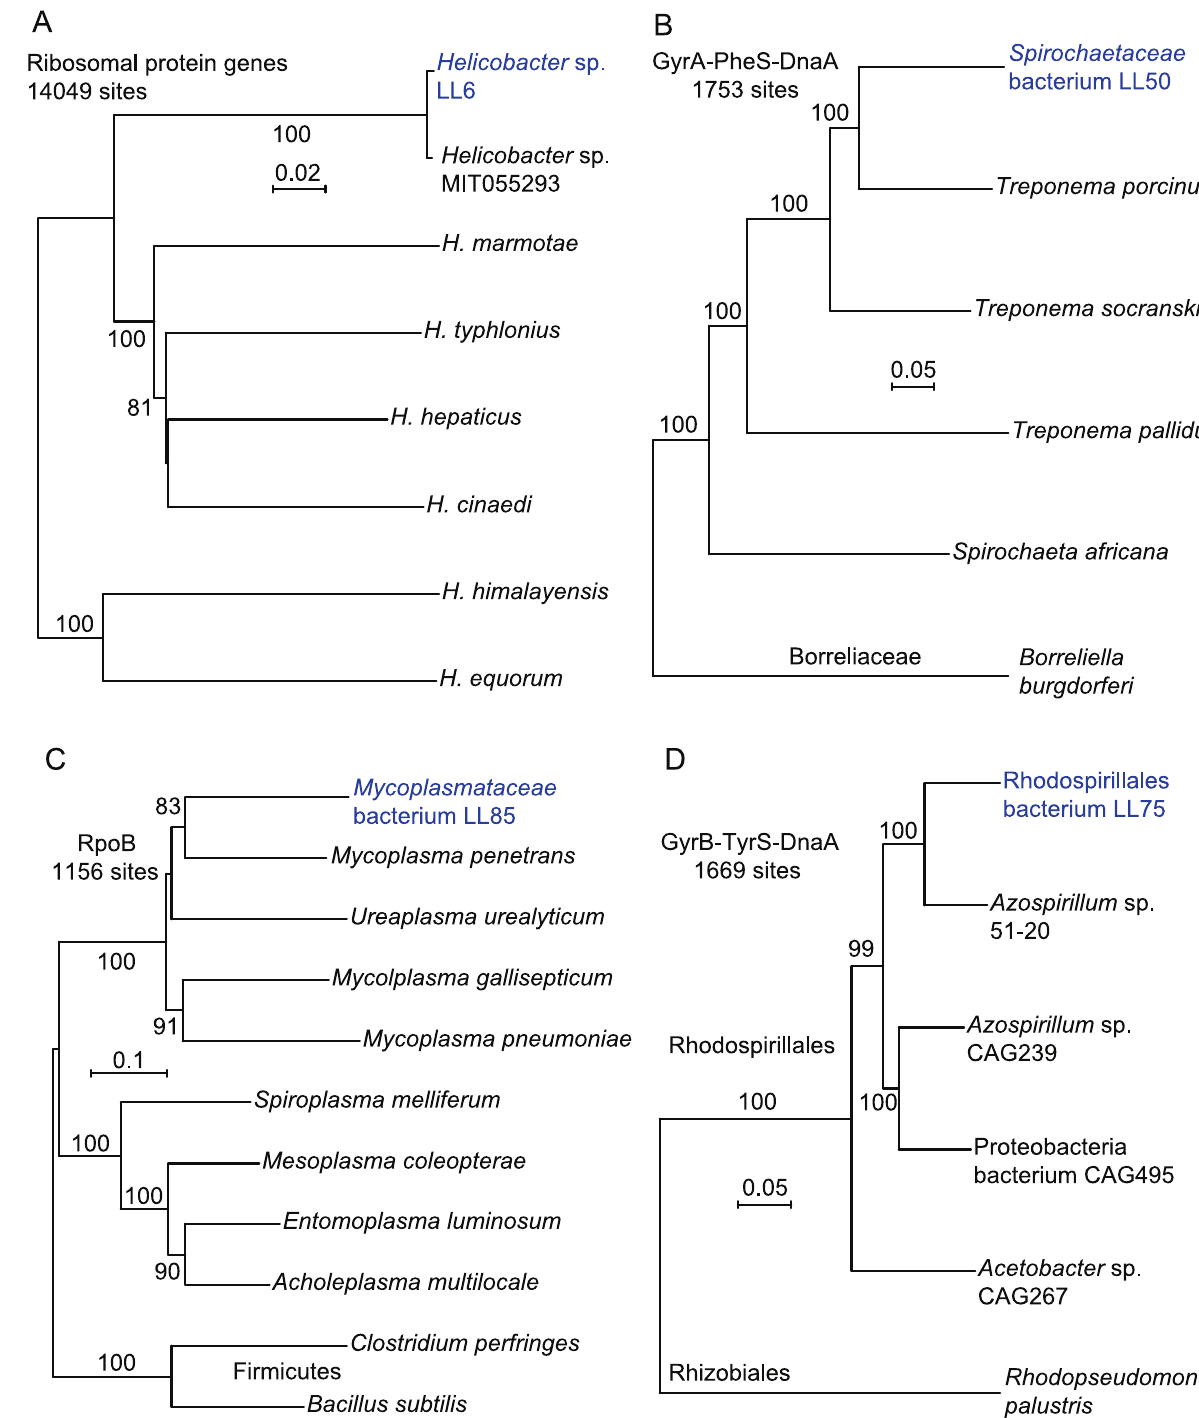
Fig 4. Neighbor-joining distance phylograms of concatenated nucleotide (panel A) or amino sequences (panels B-C) of Helicobacter spp. (panel A), Spirochaetaceae bacteria (panel B), Mollicutes and Firmicutes bacteria (panel C) and Rhodospirillales bacteria (panel D) of gut metagenome of P . leucopus and from other sources. The accession numbers for the other bacteria represented in the phylograms are given in S5 Table. The respective phylogenetic analyses used concatenated sequences of the following: ribosomal protein genes (panel A); the DNA gyrase A (GyrA), phenylalanyl t-RNA synthase, alpha subunit (PheS), and chromosomal replication iniator protein (DnaA) (panel B); DNA-directed RNA polymerase, beta-subunit (RpoB) (panel C); and DNA gyrase B (GyrB), tyrosyl t-RNA synthase (TyrS), and DnaA (panel D). The distance criteria were Jukes- Cantor for the codon-aligned nucleotide sequences and Poisson for amino acid sequences. The scales for distance are shown in each panel. Percent bootstrap (100 iterations) support values of � 80% at a node are shown.